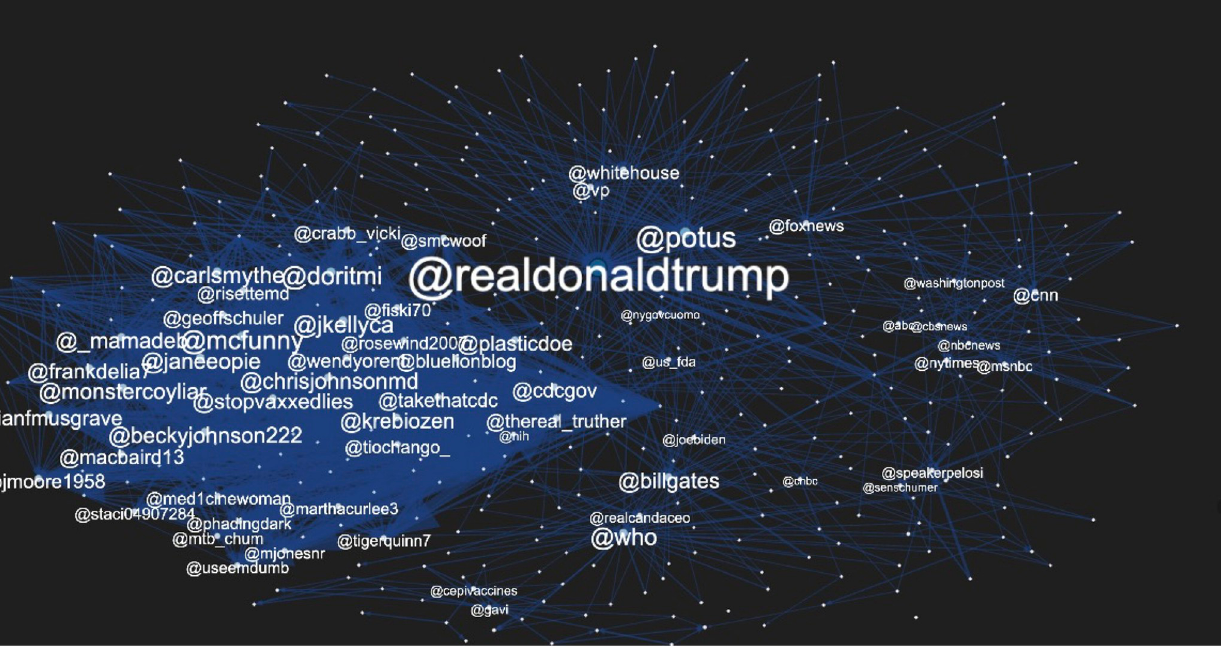
Fig 6. The mention